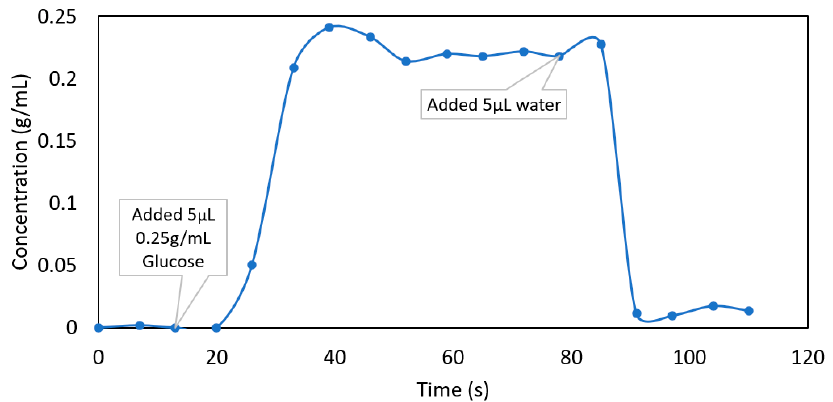
Figure 5. In-chip dynamics monitored for the microfluidic chip pre-loaded with water, as a 5 µL droplet of 0.25 g/mL glucose was added to the reservoir. The result showcases the potential of the microfluidic caged-sphere platform for practical real-time monitoring of liquids.